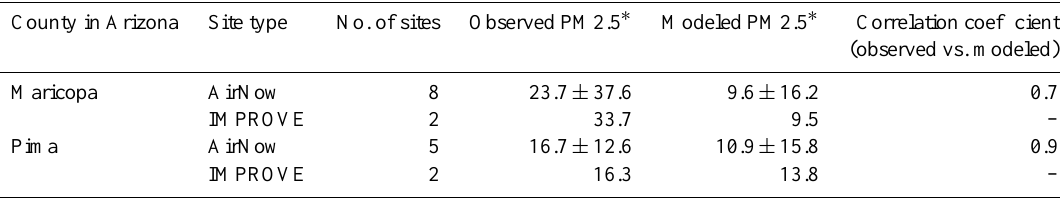
Table 2. Evaluation of NAQFC CMAQ PM2.5 predictions during a recent dust storm event on 11 May 2014. County in Arizona Site type